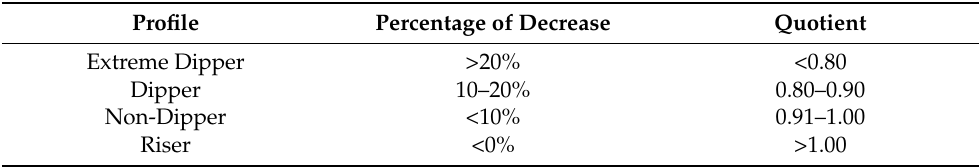
Table 1. Nocturnal blood pressure profile